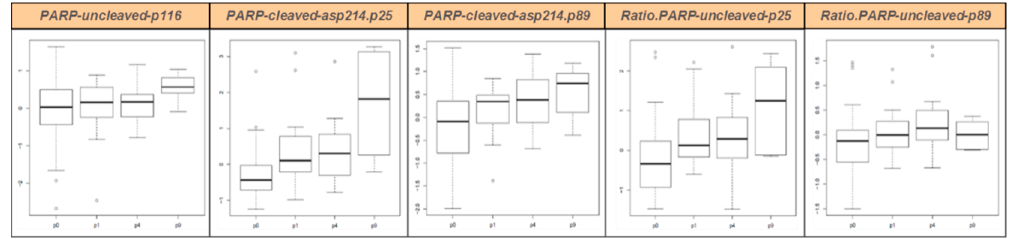
Figure 1. PARP protein expression in UM patients (P0) and their corresponding PDXs at various in vivo passages (P1, P4, and P9) as measured by RPPA. Boxplots represent the distribution of data of all PDX models together. Boxes contain 50% of values, upper brackets contain the 25% highest values, lower brackets contain the 25% lowest values. Black lines: median; dots: outliers. P0, patient’s tumor; P1, first in vivo passage; P4, fourth in vivo passage; P9, ninth in vivo passage.